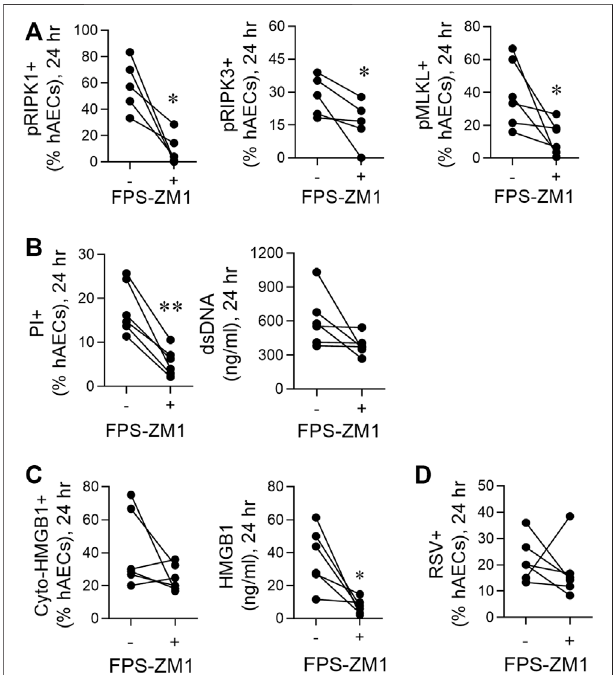
FIGURE 4 | RSV-induced necroptosis is mediated via a HMGB1/RAGE axis. hAECs were pre-treated with or without a RAGE antagonist (FPS-ZM1) and infected with RSV (MOI of 1). Endpoints were assessed at 24 h post infection. (A) Quanti fi cation of pRIP1K, pRIPK3 and pMLKL positive hAECs. (B) Quanti fi cation of PI positive hAECs and dsDNA levels in the supernatant. (C) Quanti fi cation of cytoplasmic HMGB1 positive hAECs and HMGB1 protein expression in the supernatant. (D) Quanti fi cation of RSV positivecells. Dataare presented asdot plots with each data point represents one of 6 donors. Data were analyzed using a paired T-test. * p < 0.05, ** p < 0.01, denotes signi fi cance betweenRSV-infected cells treated with orwithout RAGE